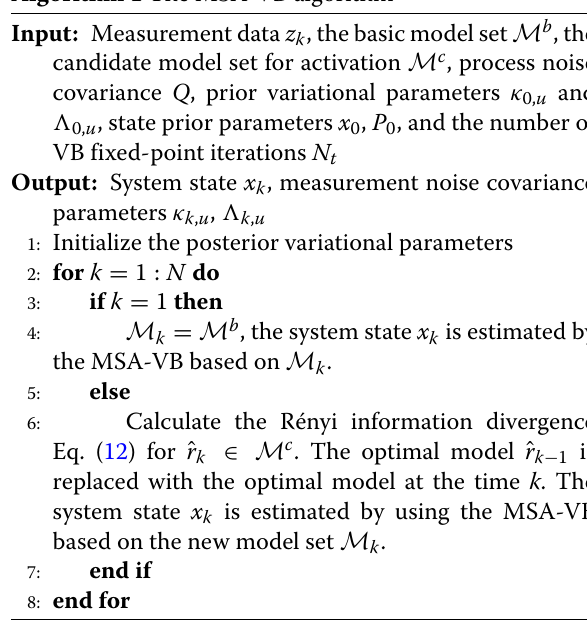
Algorithm 1 The MSA-VB